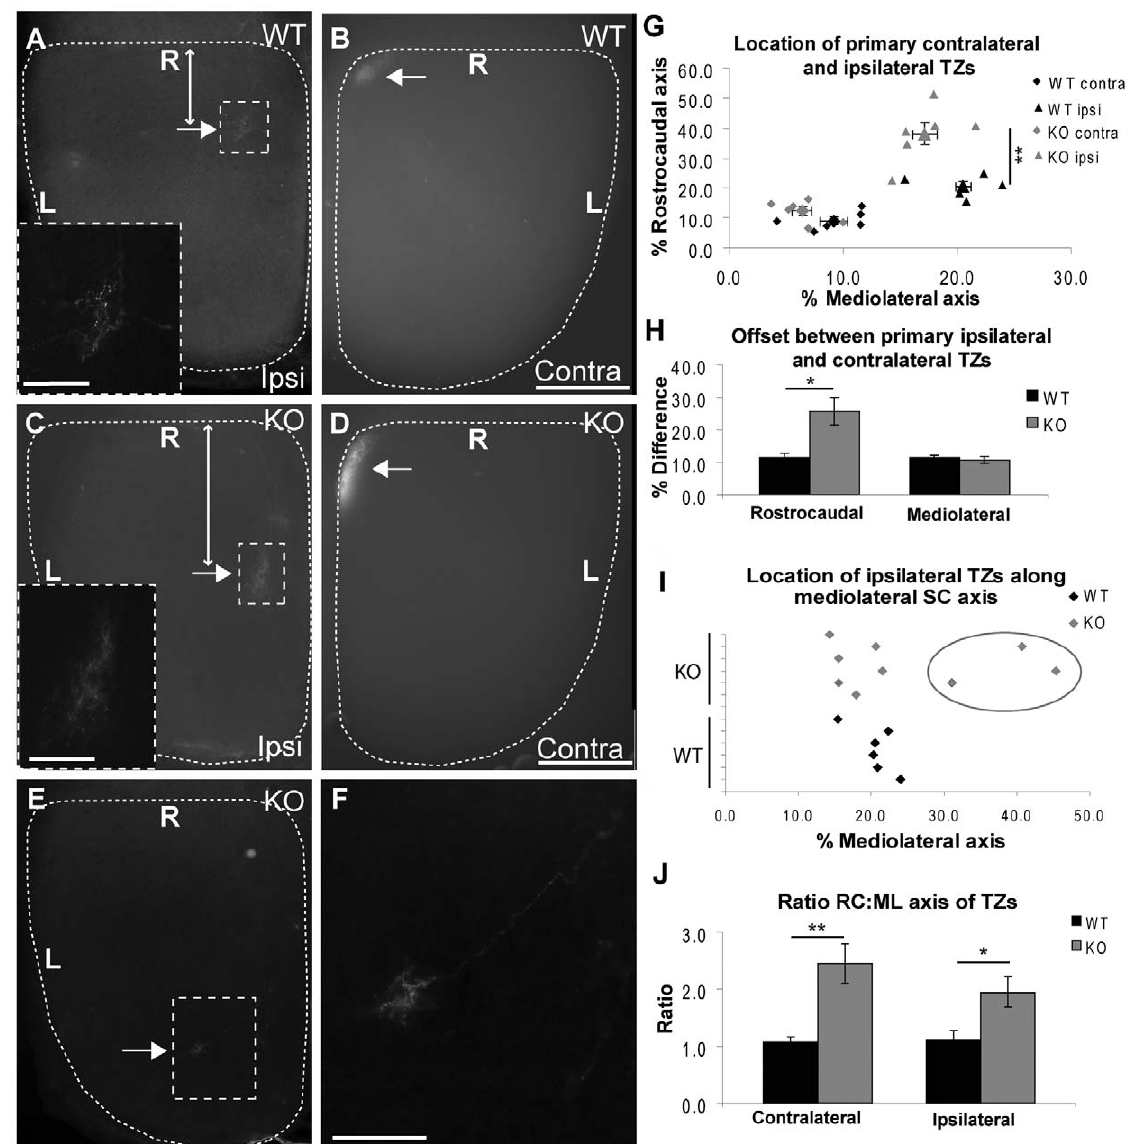
Figure 6. Deletion of Ten-m3 results in mapping changes along the RC and ML axes of the SC. A–B: Horizontal section through the ipsilateral SC (A) and whole-mount preparation of the contralateral SC (B) following an injection of DiI into the VTC from a P11 WT mouse. The contralateral TZ forms a densely labelled region near the rostromedial corner of the SC (B, arrow). The ipsilateral TZ (arrow, boxed region also shown at higher power in inset; A) arising from the same injection is offset caudally and laterally, and is located at around 20% of the distance along each collicular axis. The distance of the centre of the ipsilateral TZ from the rostral border of the SC is marked by a double-headed arrow. Borders of the SC are indicated by dashed lines. C–D: As for A–B but from a Ten-m3 KO mouse. The contralateral TZ occupies a similar location to that in WT at the rostromedial corner of the SC (D, arrow). The primary ipsilateral TZ occupies a similar location to WT along the ML axis (around 18%), but is shifted much further caudally along the RC axis (41%; C, arrow). Note the increase in the length of the double-headed arrow in the KO (C) which marks the distance of the ipsilateral TZ from the rostral border of the SC compared to the WT example (A). E–F: Adjacent (deeper) section to that shown in C, revealing the location of a secondary ipsilateral TZ (boxed region, shown at higher power in F). The secondary TZ is displaced both caudally (at 75% of the RC axis) and mediolaterally (at 40% of the SC axis) from the primary TZ. An additional labelled axon can also be seen (F) but did not form a clear TZ. G: Scatter plot showing the location of the centre of the primary contralateral and ipsilateral TZs in 6 WT and 6 Ten-m3 KO mice. Means 6 standard errors (s.e.) are also plotted. Contralateral TZs were centred at around 10% of each axis in WT whereas ipsilateral TZs are located significantly further caudally and laterally compared to contralateral TZs, at around 20% of each axis (p , 0.05, Student’s t-test, see results). The distribution of contralateral TZs in Ten-m3 KO overlaps with that of WT for both axes (p . 0.05, Multivariate ANOVA, see results). The location of the primary ipsilateral TZ in Ten-m3 KOs overlaps with that of the WT ipsilateral TZs along the ML axis (p . 0.05. Multi-variate ANOVA, see results). The location of the primary ipsilateral TZs are, however, significantly further caudal than in WTs, at around 40% of the RC axis (p , 0.01, Multivariate ANOVA, see results). H: Graph plotting the offset of the primary ipsilateral and contralateral TZs in WTs and Ten-m3 KOs. Their separation along the ML axis of the SC is identical between KOs and WTs (p . 0.6, Student’s t-test, see results), but is significantly increased along the RC axis in KOs (p , 0.05, Student’s t- test, see results). I: Plot showing the distribution of both primary and secondary ipsilateral TZs along the ML axis of the SC. The presence of a laterally- shifted, secondary TZ in 3 out of 6 KOs is highlighted by the grey ring. Laterally-shifted, secondary TZs are not observed in any WTs. J: Graph illustrating a significant increase in the ratio of RC to ML (RC:ML) axes of TZs in the SC for both contralateral and ipsilateral retinocollicular projections